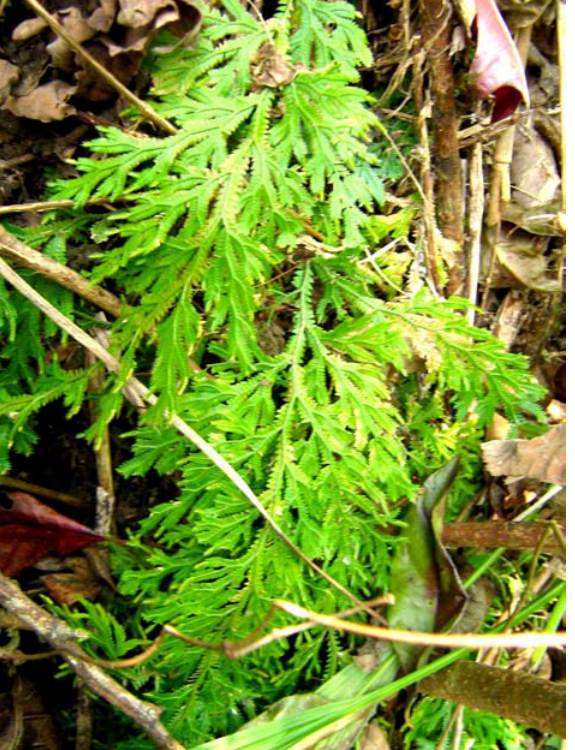
Image 5. Selaginella